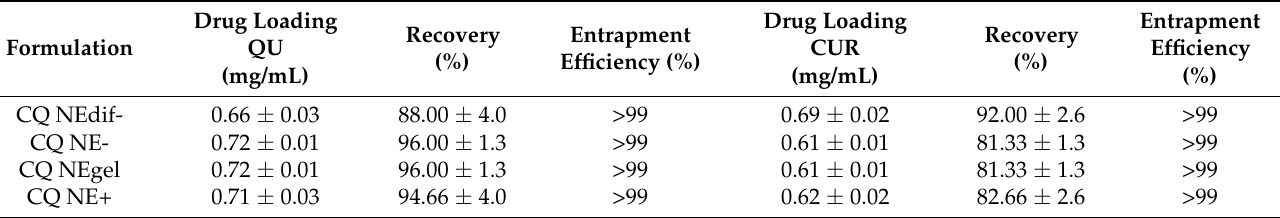
Table 5. Drug content, recovery, and entrapment efficiency of the